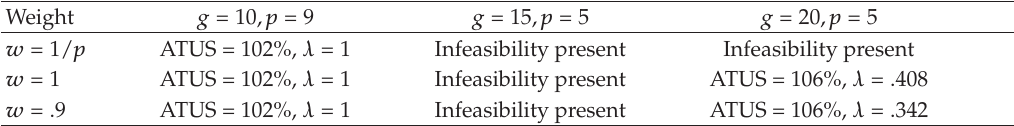
Table 2: Solution of proposed method 2.